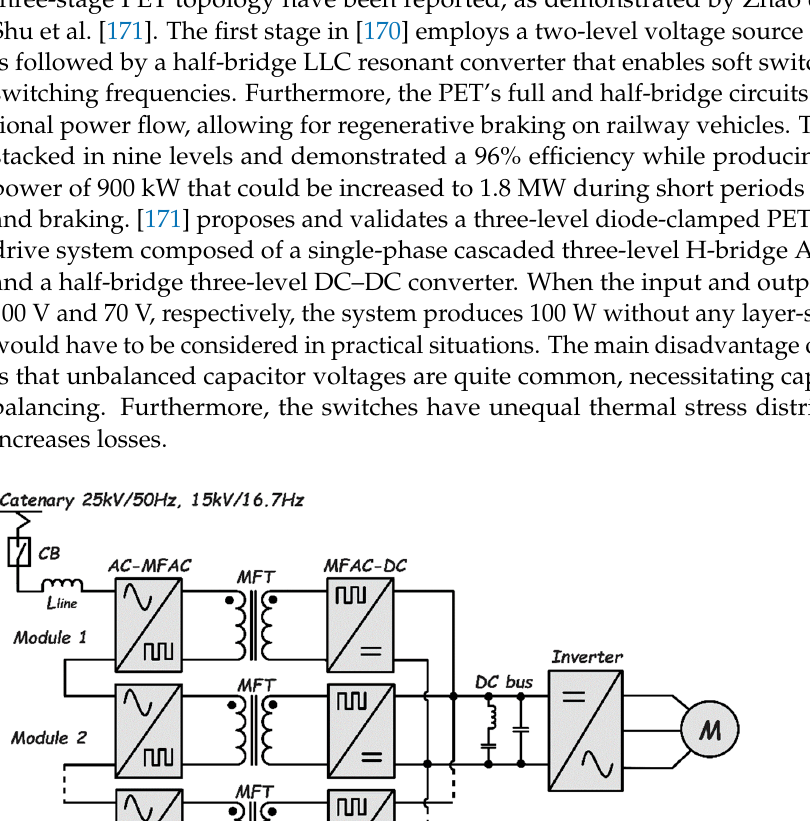
Figure 15. Conventional traction motor drive system based on LFT.